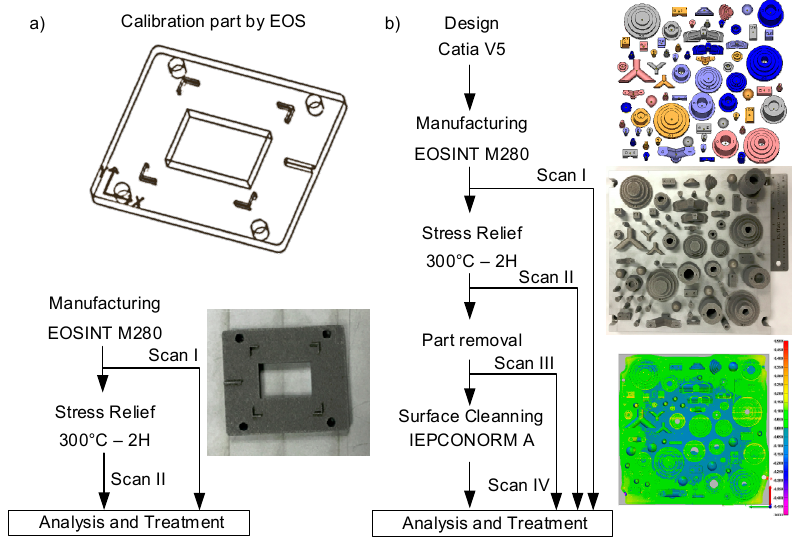
Figure 2. Experimental protocol: ( a ) Beam offset correction, ( b ) Test artifacts GDEs .